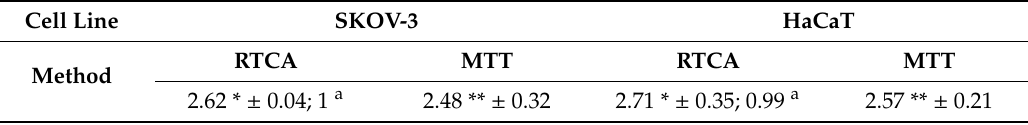
Figure 2. The SKOV-3 cells’ viability declines after the treatment with α -HN. The SKOV-3 cells were incubated with α -HN for 24 h. The curves are labeled with numbers that represent increasing concentrations of α -HN (1–70 µ g / mL, respectively). Table 1. The mean values of IC 50 ( µ g / mL) of α -HN on the grounds of Real-Time xCELLigence system and MTT assays for SKOV-3 and HaCaT cell